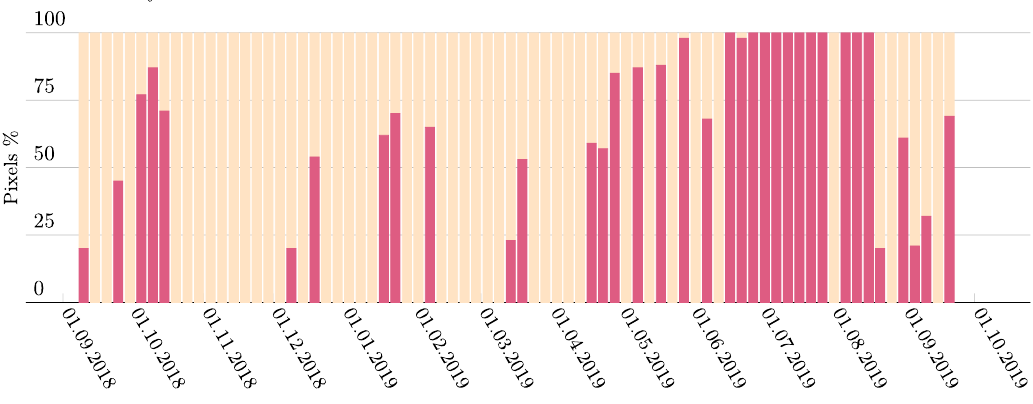
Figure 11. The percentage of pixels used for analysis after the removal of clouds and cloud shadows in our one-year dataset.